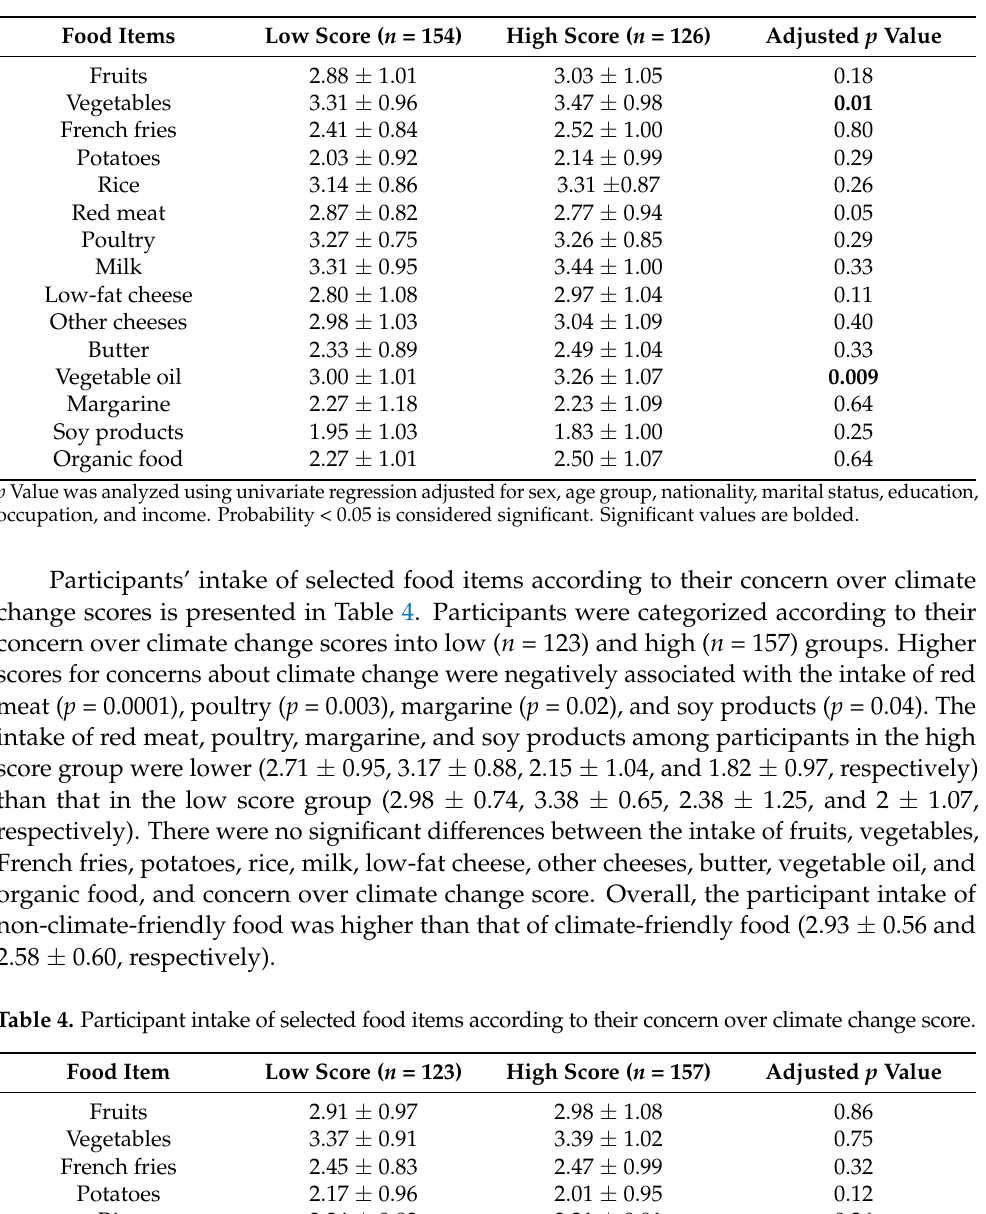
Table 3. Participants’ intake of selected food items according to their understanding of climate change score.